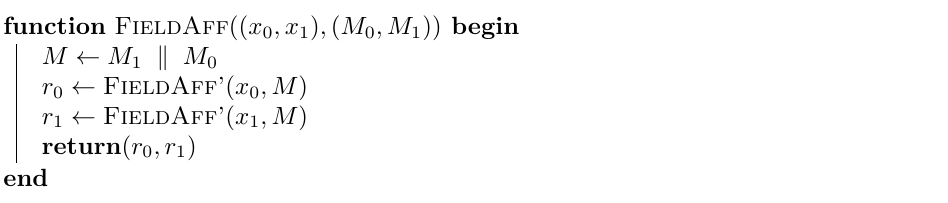
Algorithm 22: FieldAff : apply packed F masking).